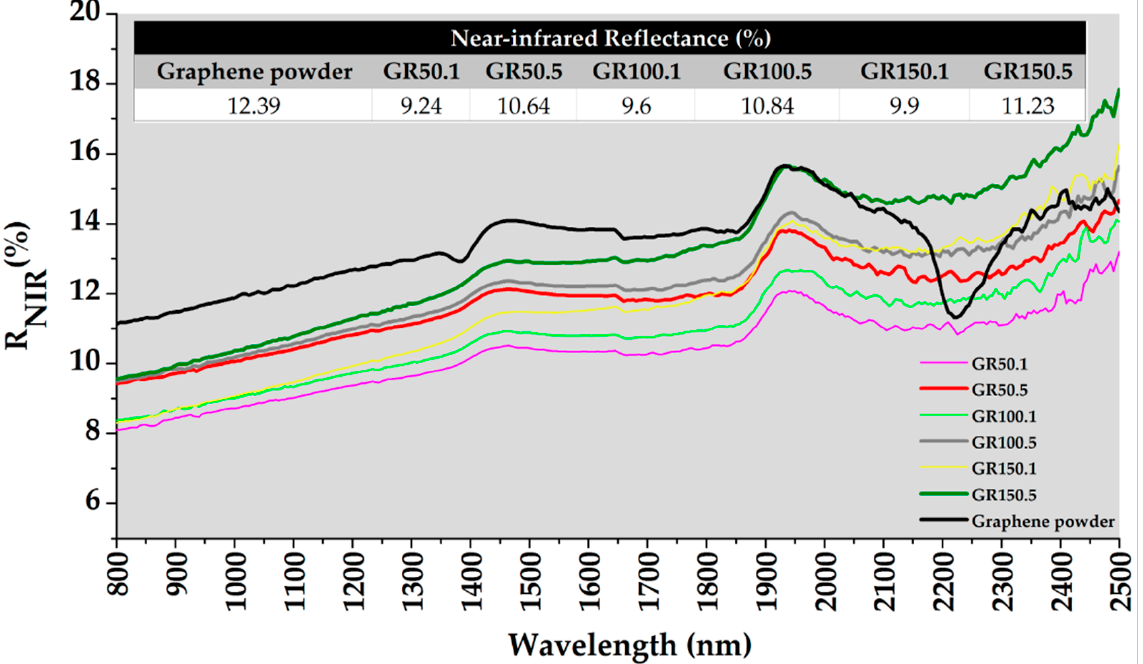
Figure 11. Near-infrared reflection ( R NIR ) results of graphene powder and coated fabrics.